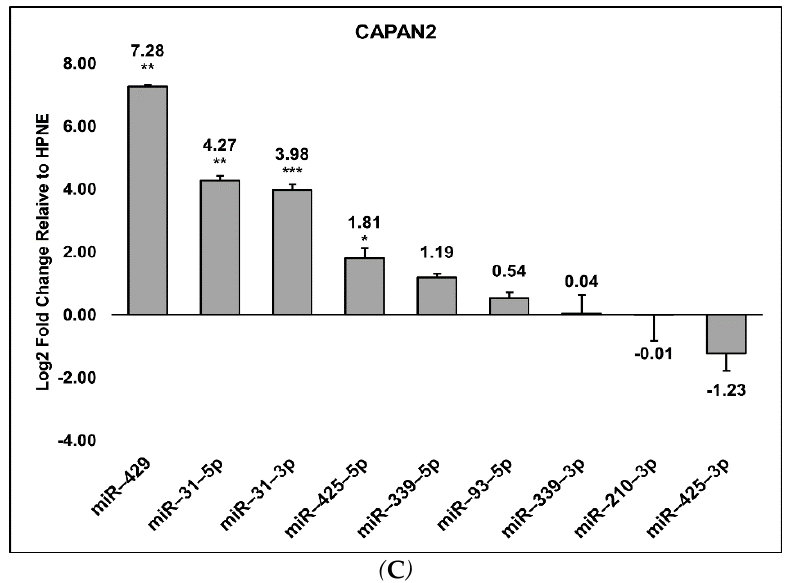
Figure 2. Relative expression levels of MIRs detected in PANC1, BXPC3, and CAPAN2 compared to HPNE. The log2 fold changes of the relative expression levels of miRs in the three different PDAC cell lines, PANC1 ( A ), BXPC3 ( B ), and CAPAN2 ( C ) compared to HPNE was calculated. The log2 fold change was calculated via ΔΔ Cq values. Significant ( p ≤ 0.05, *), very significant ( p ≤ 0.01, **), and extremely significant ( p ≤ 0.001, ***) are also noted and determined using the student’s t-test.